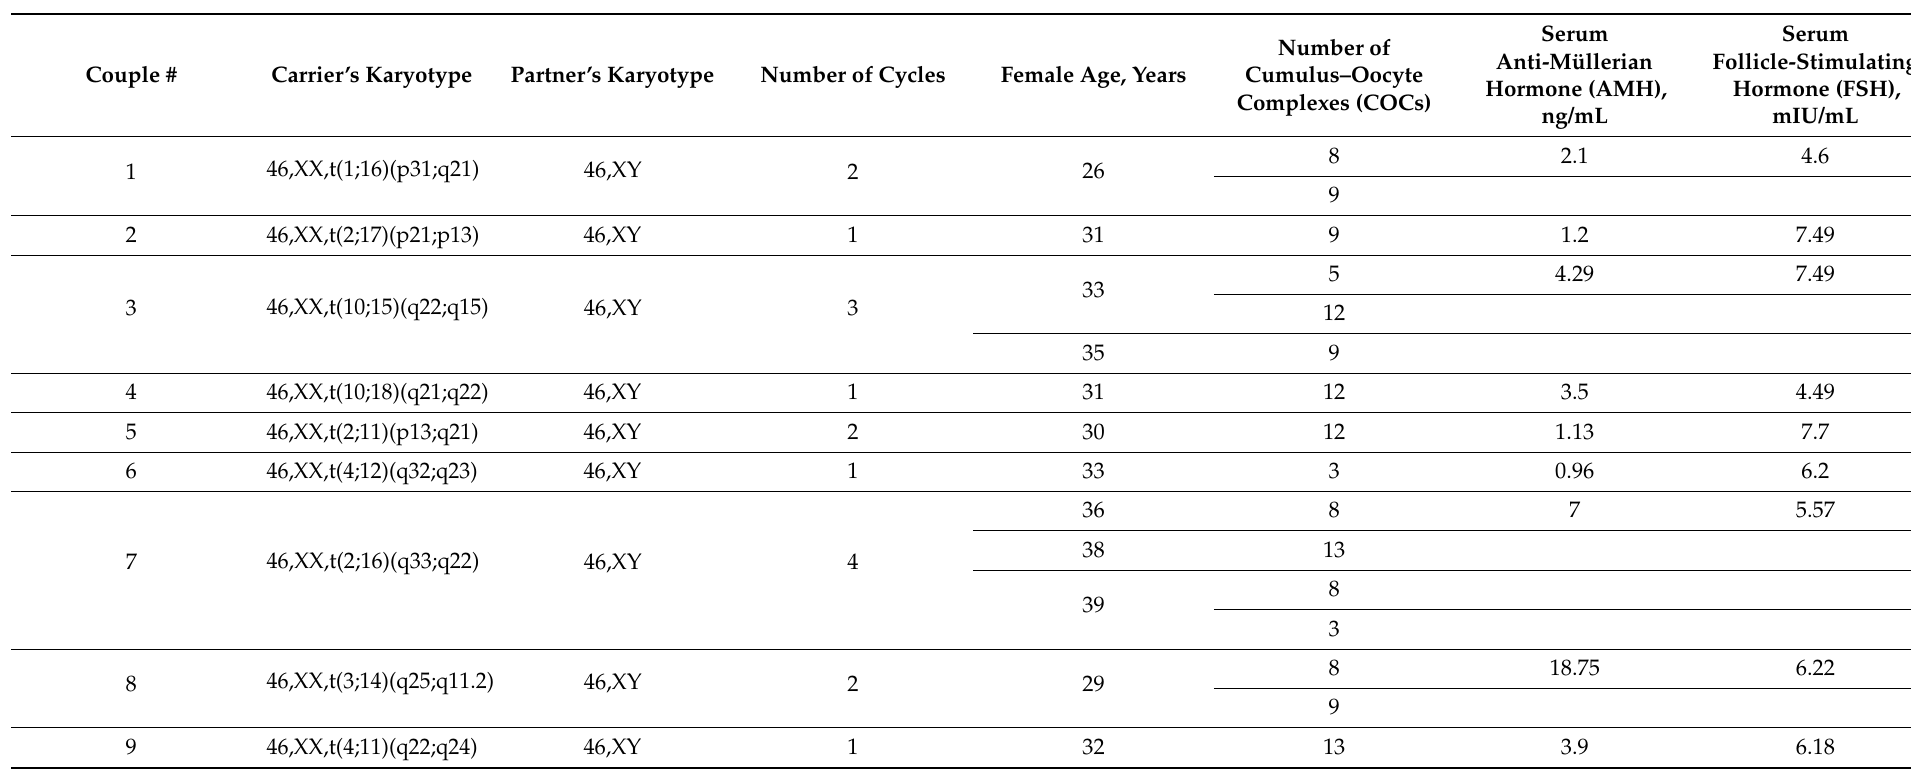
Table A1. Clinical characteristics of the patients from the couples referred for in vitro fertilization/preimplantation genetic testing for structural rearrangement (IVF/PGT-SR) for balanced